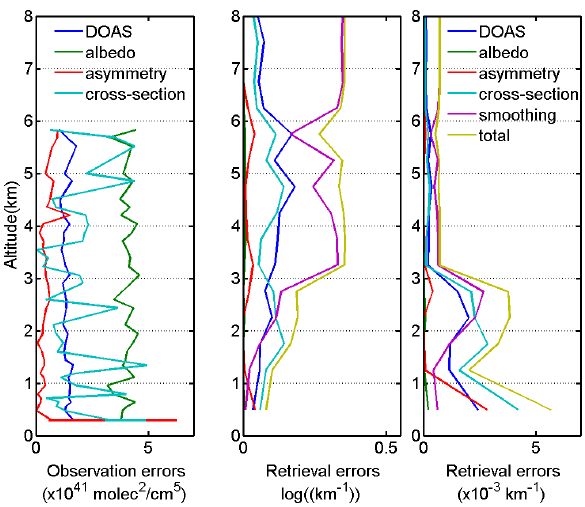
Fig. 5. Construction of the a priori aerosol extinction coefficient profile (red) from the measured relative humidity (black). The extinction values are derived for 350 nm from the software package OPAC, using the Arctic Spring predefined aerosol type.